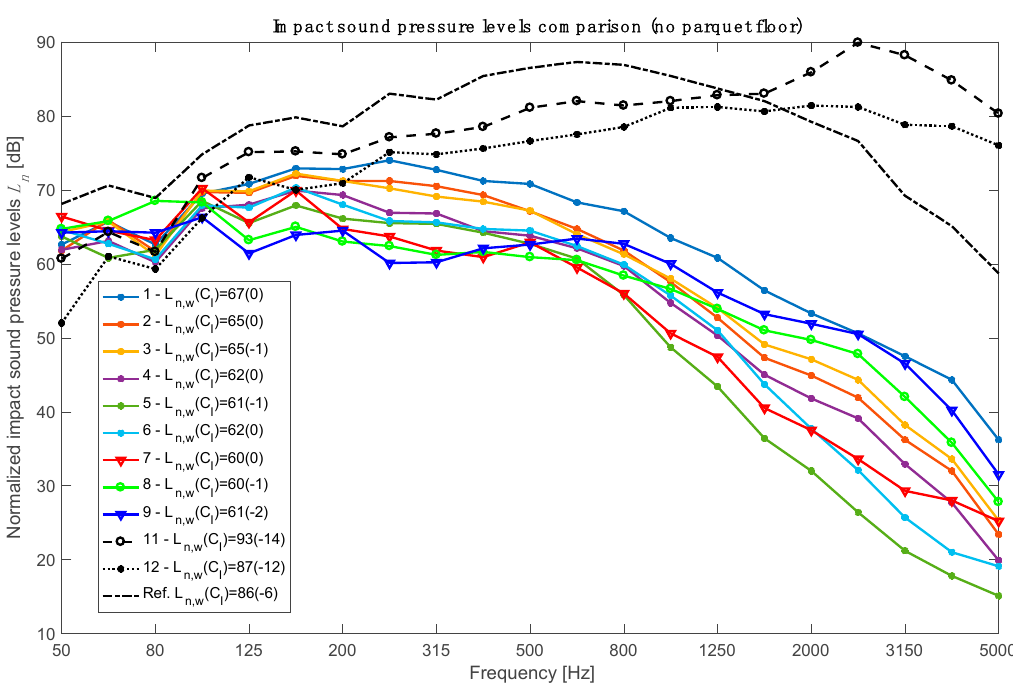
Figure A2. Normalized impact sound pressure levels L n of the test floors without a parquet floor on top. Floor 10 was not measured without a parquet floor (missing data).